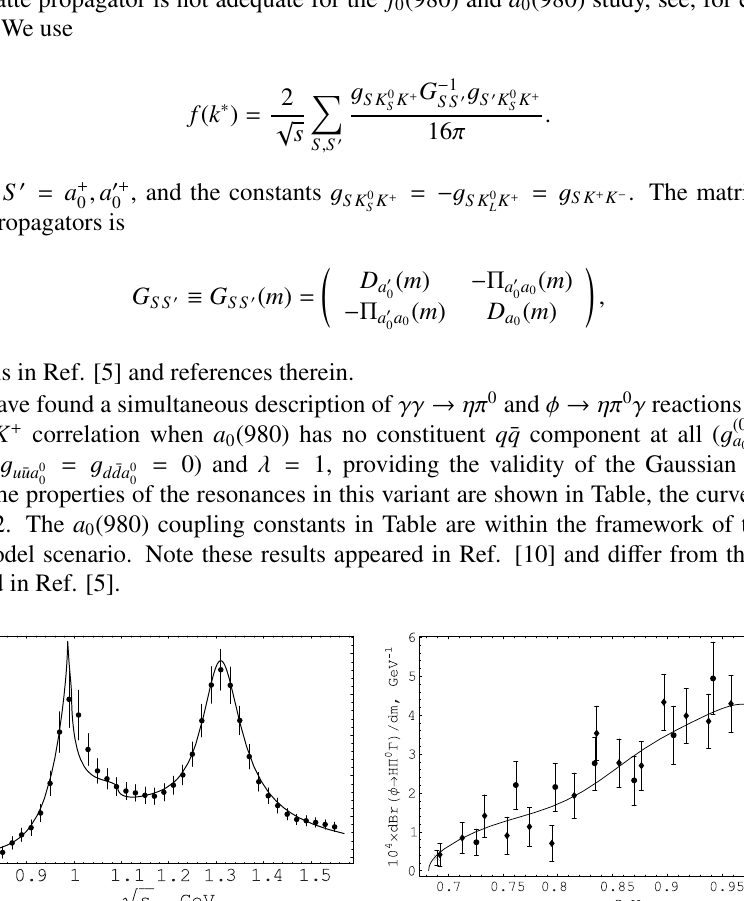
ηπ 0 cross section, our curve and the experimental data [3]. (b) The φ Figure 1. (a) The γγ → decay, cross points are omitted in the fitting. The data is from